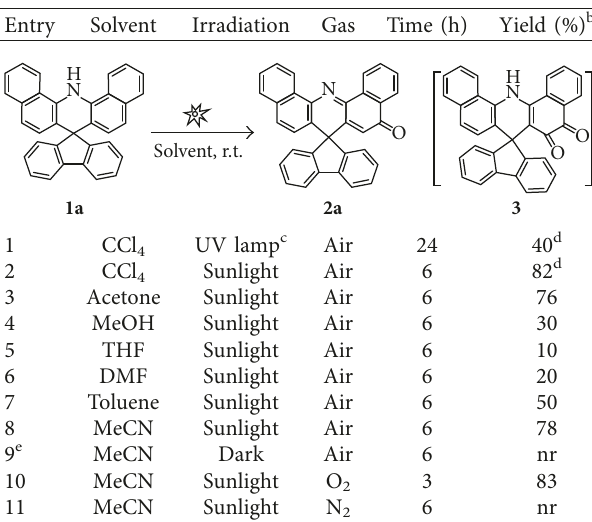
Table 1: Optimization of the reaction conditions a